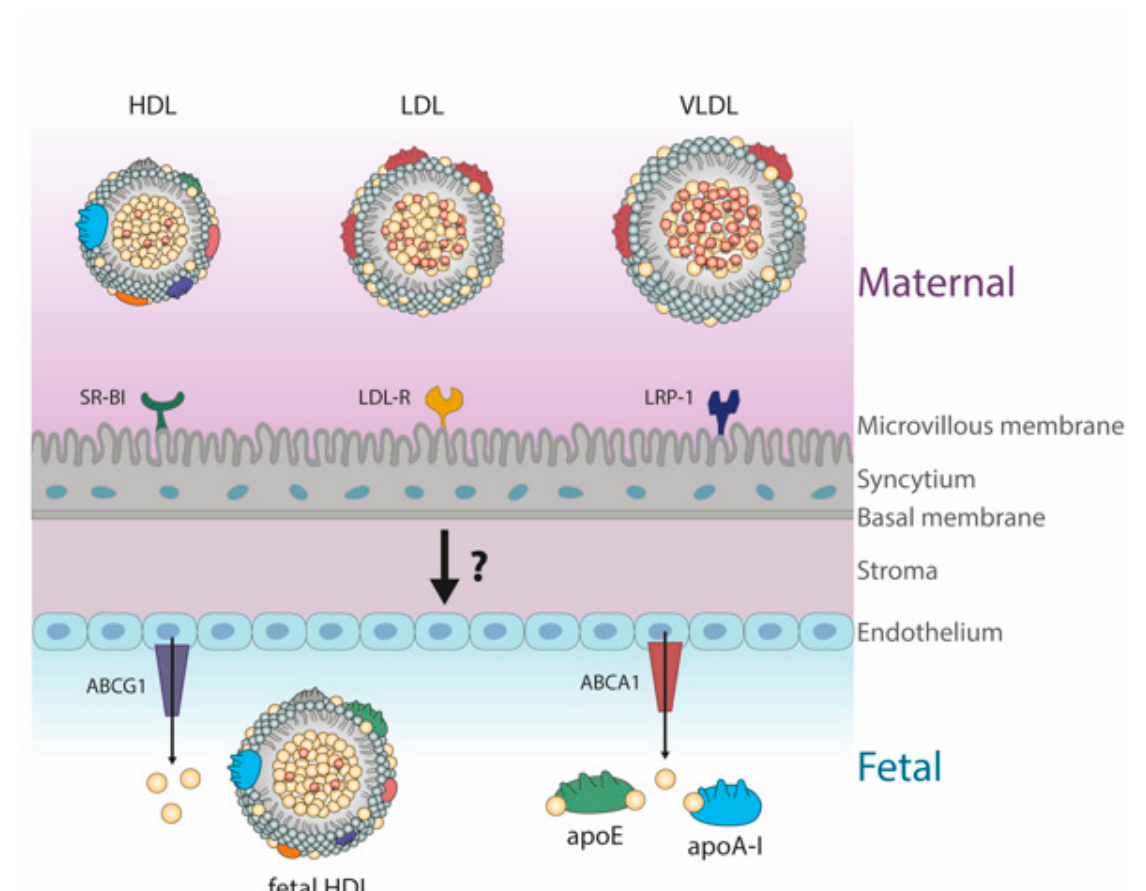
Figure 1. Described routes how maternal cholesterol is transported across the human placenta. First, maternally derived lipoproteins interact with respective receptors at the microvillous membrane of the syncytium. After uptake of cholesterol in the syncytium, it is secreted/effluxed to lipid ‐ poor acceptor apolipoproteins of fetal HDL. How stroma transfers cholesterol to the fetoplacental endothelium remains elusive. High ‐ density lipoprotein; SR ‐ BI; scavenger receptor BI; LDL, low ‐ density lipoprotein; VLDL, very ‐ low ‐ density lipoprotein; LDL ‐ R, low ‐ density lipoprotein receptor; LRP ‐ 1, LDL receptor ‐ related protein 1; ABCA1, ATP ‐ binding cassette A1; ABCG1, ATP ‐ binding cassette G1.